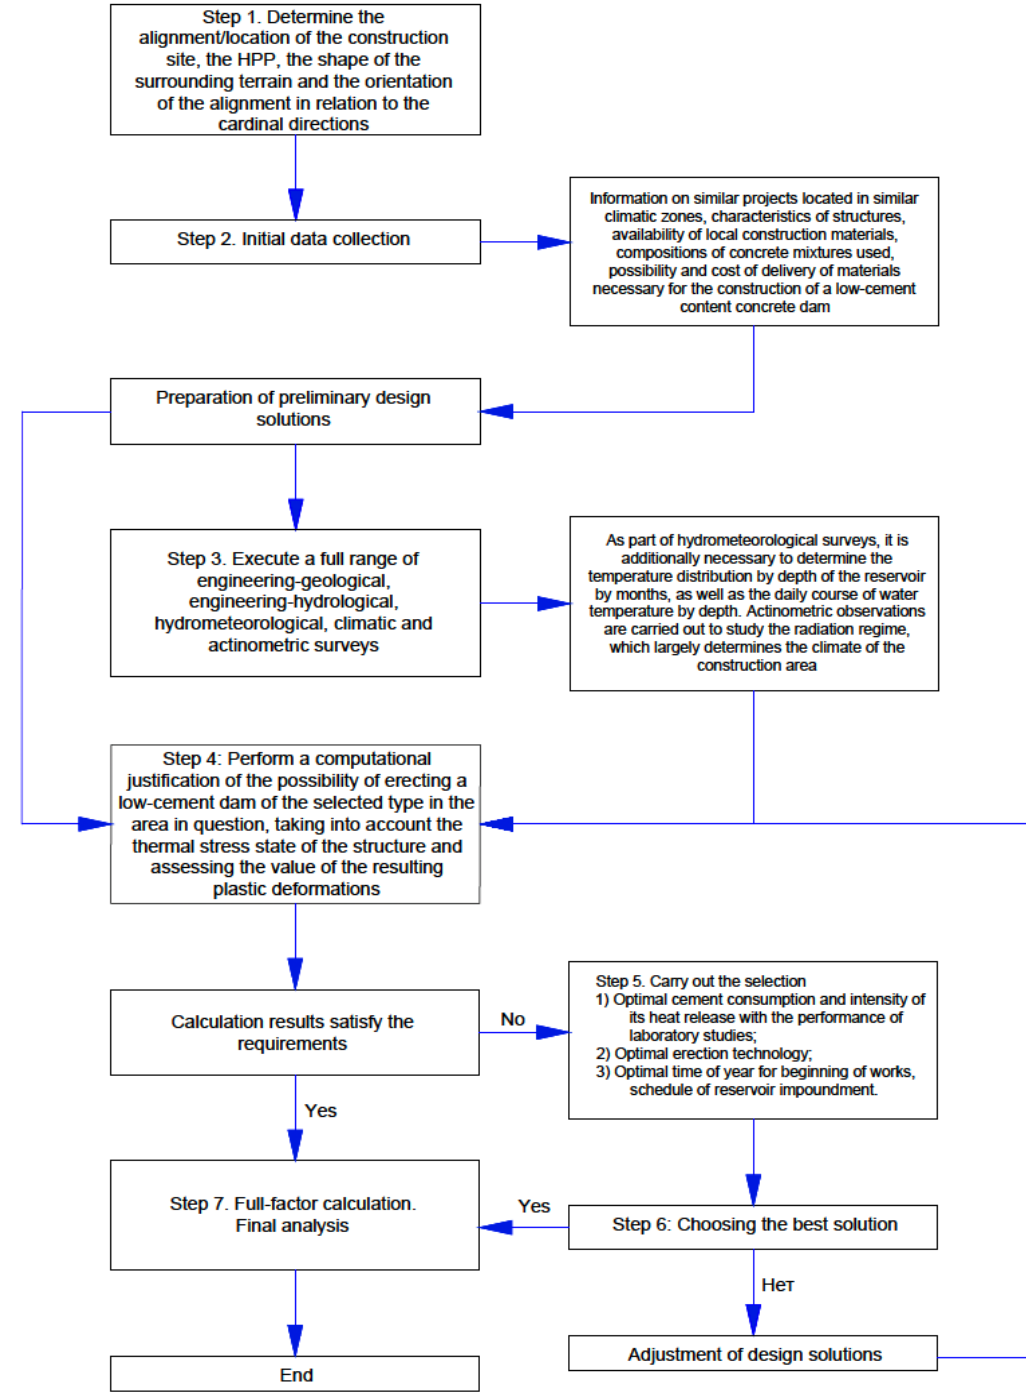
Figure 17. Algorithm for the design of a low - cement concrete dam.